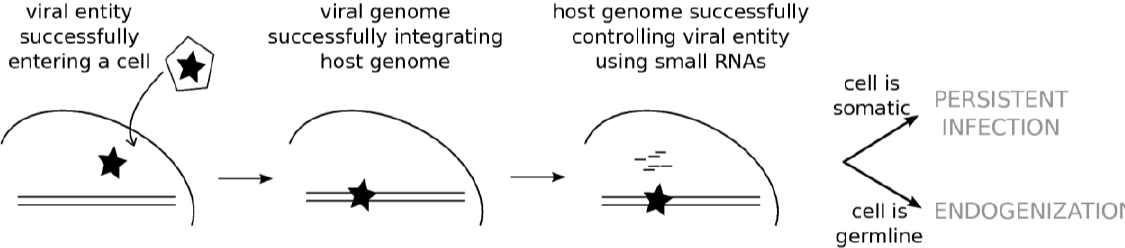
Figure 3. Endogenization and Persistent Infections Originate from Comparable Mechanisms. Endogenization of retroviral sequences results from the infection of